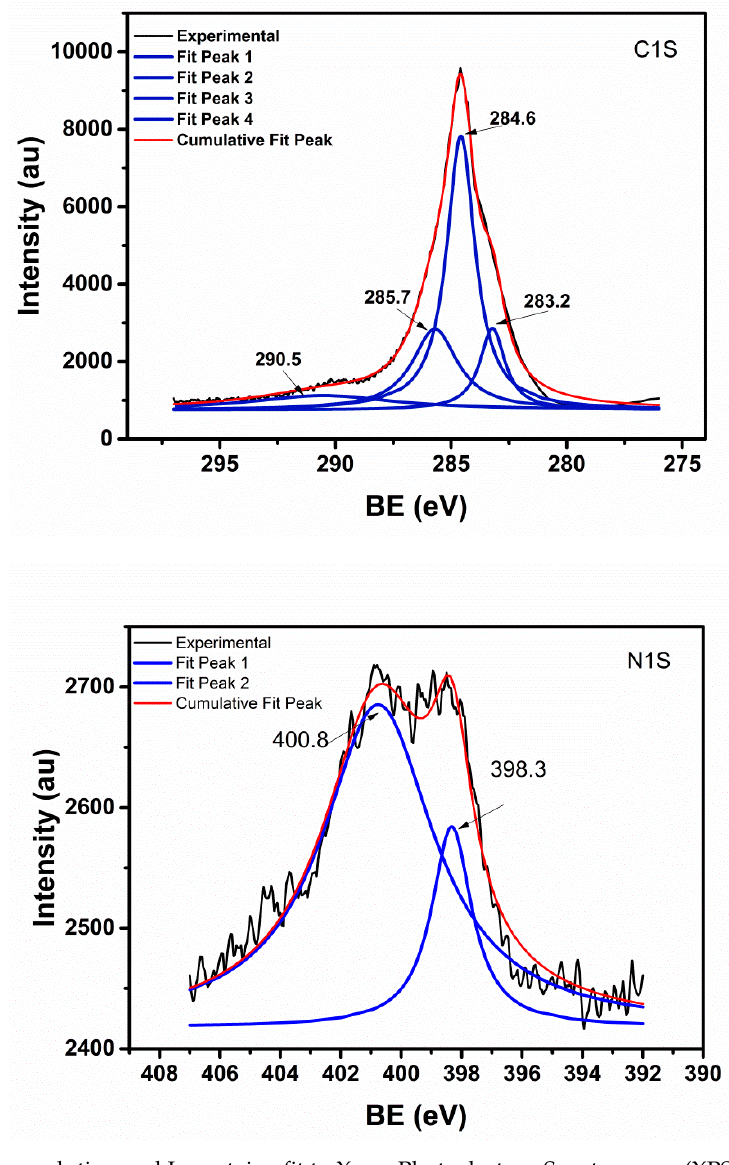
Figure 9. Deconvolution and Lorentzian fit to X-ray Photoelectron Spectroscopy (XPS) data for C1s and N1s peaks of sample H1.